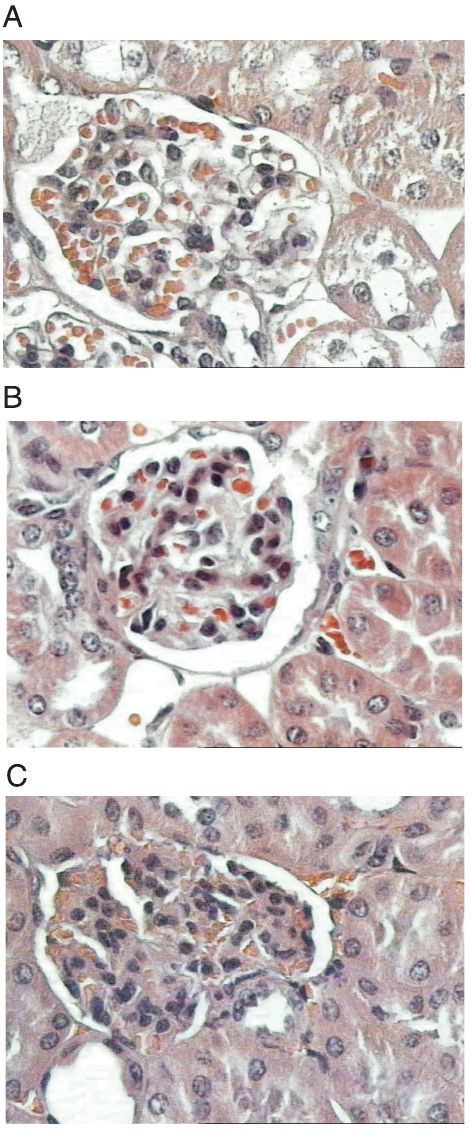
Figure 1. A , Glomerulus from a normal maximal acute inflam- matory response (AIRmax) mouse. Hematoxylin-eosin (HE), 360X. B , Glomerulus from an AIRmax mouse with mesangial proliferation. HE, 360X. C , Glo- merulus from a minimal AIR (AIRmin) mouse with synechiae and mesangial expansion. HE,